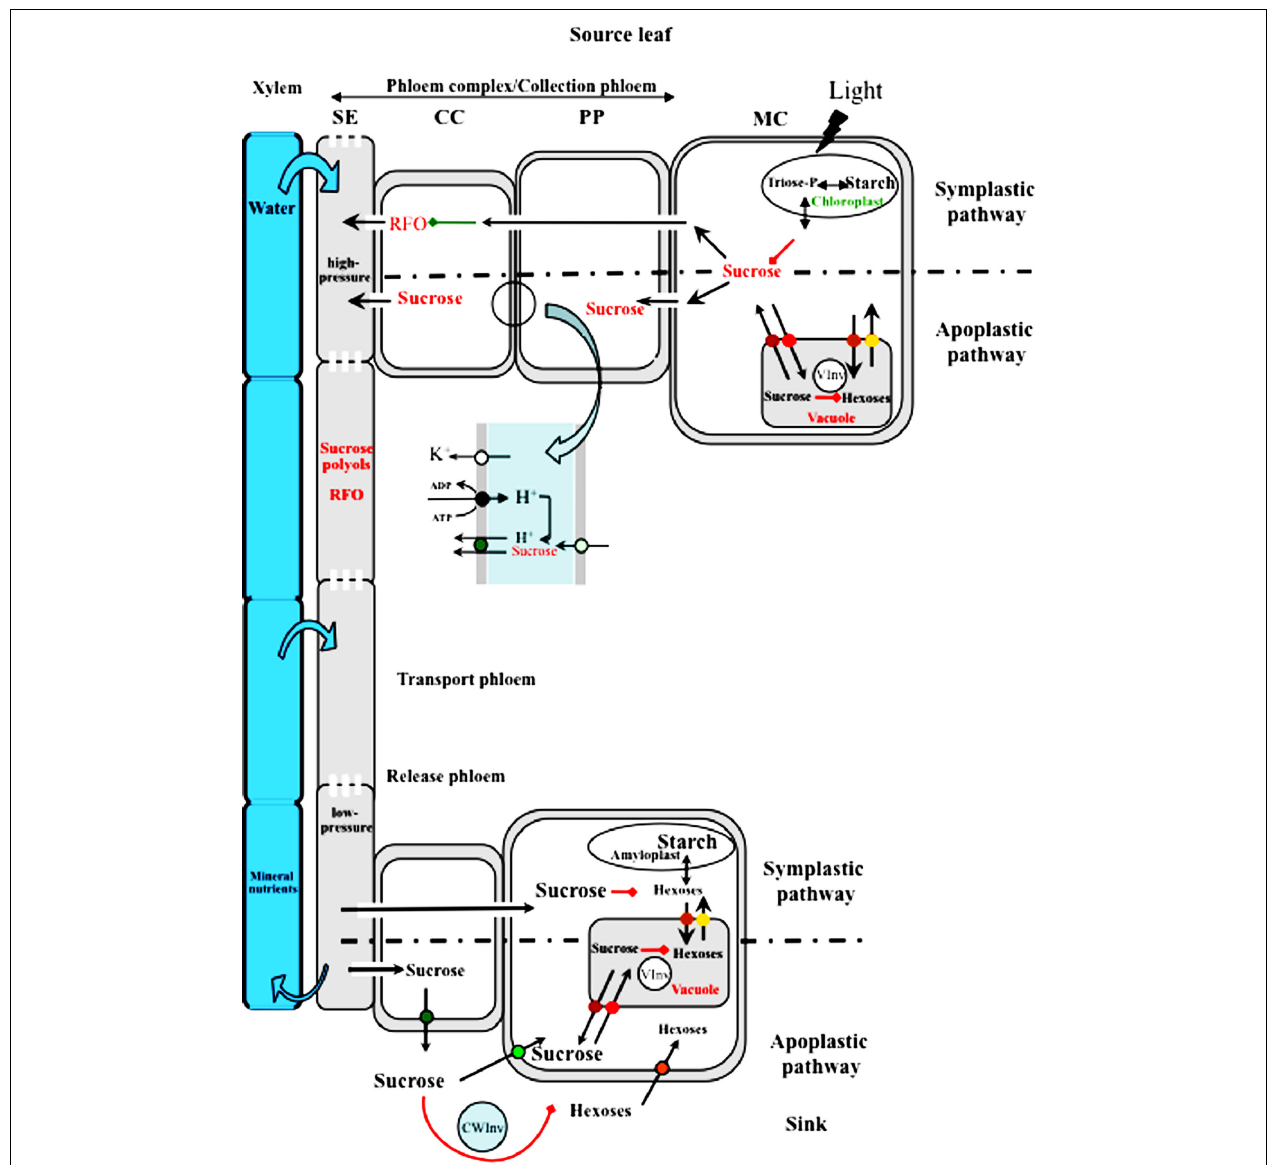
FIGURE 1 | Comparison of source-to-sink sugar transport in symplastic and apoplastic active phloem loaders. Sucrose available for export from mesophyll cells (MC) results from a balance between storage in the vacuoles and sequestration as starch in the chloroplasts. Sucrose can reach the sieve tubes through plasmodesmata that allow for its diffusion from cell to cell in species like cucurbits. Sucrose is converted to larger molecules (RFOs) by the sequential addition of galactosyl residues in modified companion cells (CC) called intermediary cells.The larger molecules cannot move back to phloem parenchyma cells (PP) and are transferred and accumulated in sieve tubes. In apoplast-loading species, sucrose reaches phloem parenchyma cells through plasmodesmata. Sucrose is loaded and accumulates in the phloem by passing through the apoplast between the PP and the CC.The major players are presented in the enlargement of that area. Sucrose enters the apoplast through facilitators of the SWEET family (pale green circle) and is accumulated in the companion cell by a proton/sucrose co-transporter of the SUT1/SUC2 type (green circle).The energy necessary for the co-transport is provided by an H + /pumping ATPase (black circle) which establishes a proton gradient and a trans-membrane potential regulated by potassium channels of the AKT2/3 type (white circle). In Solanaceous species, SUT1 transporters